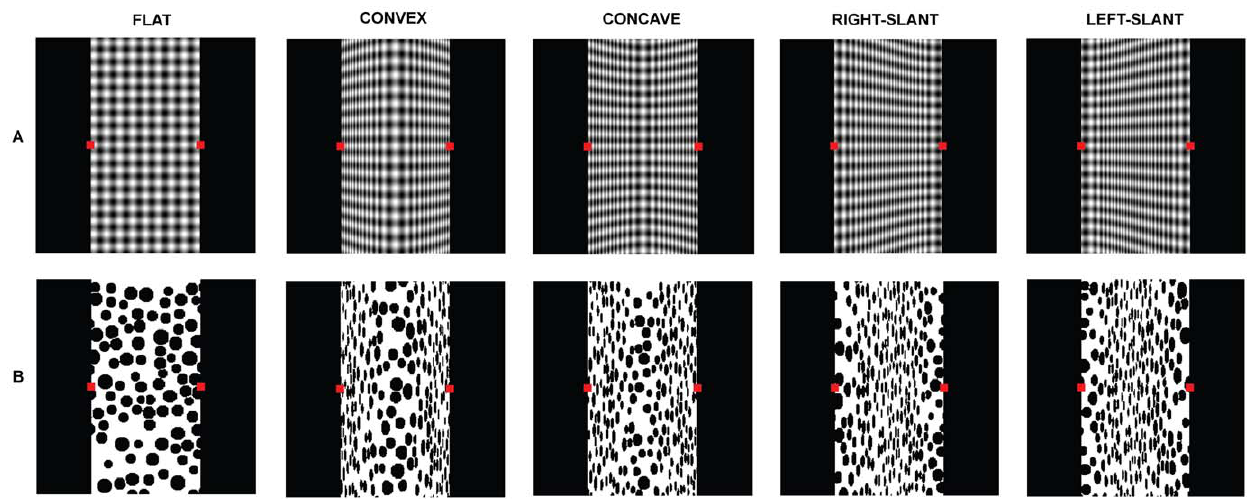
Figure 1. Veridical and non-veridical percepts of 3-D shapes conveyed by surface textures. (A) Flat fronto-parallel surface and half-cycles of a 3-D vertical sinusoidal corrugation covered with horizontal-vertical plaid textures. (B) Identical surfaces covered with random-dot textures.